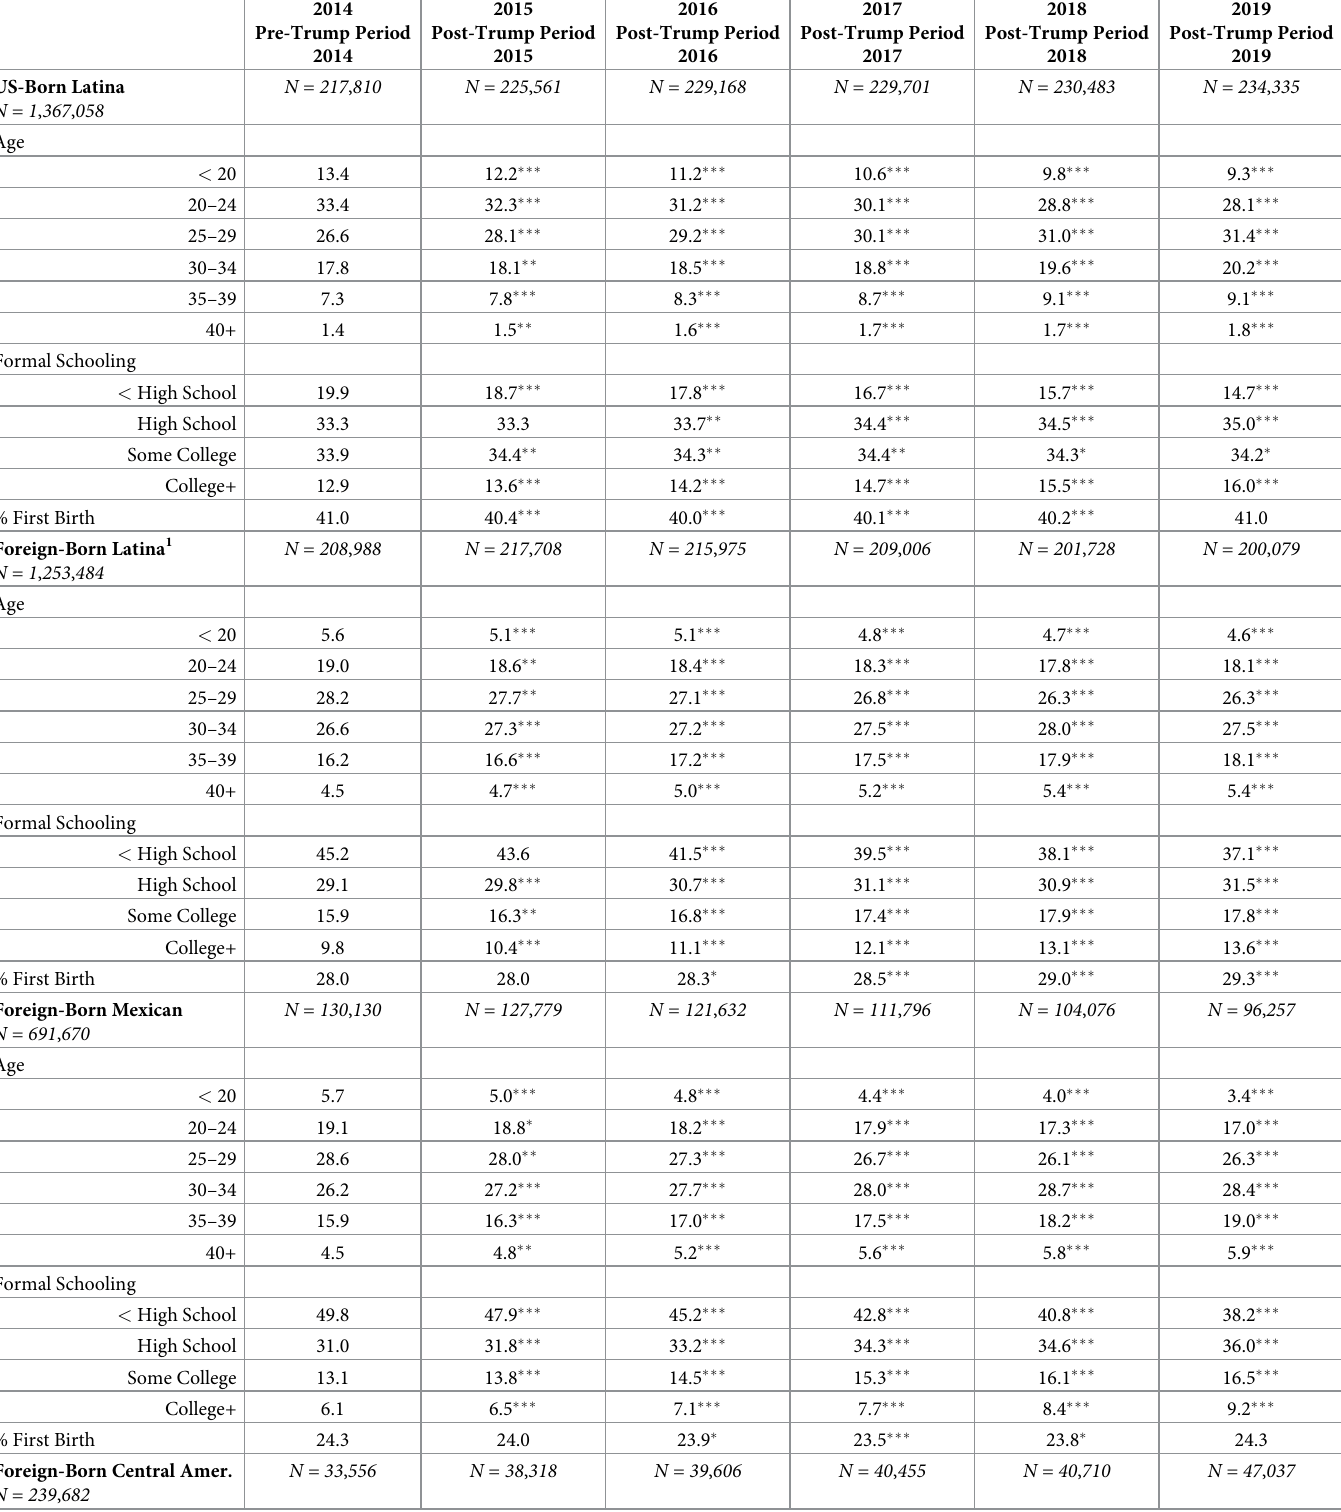
Table 2. Descriptive statistics on maternal characteristics for US resident mothers across study periods (July 1 to Dec 31 in years